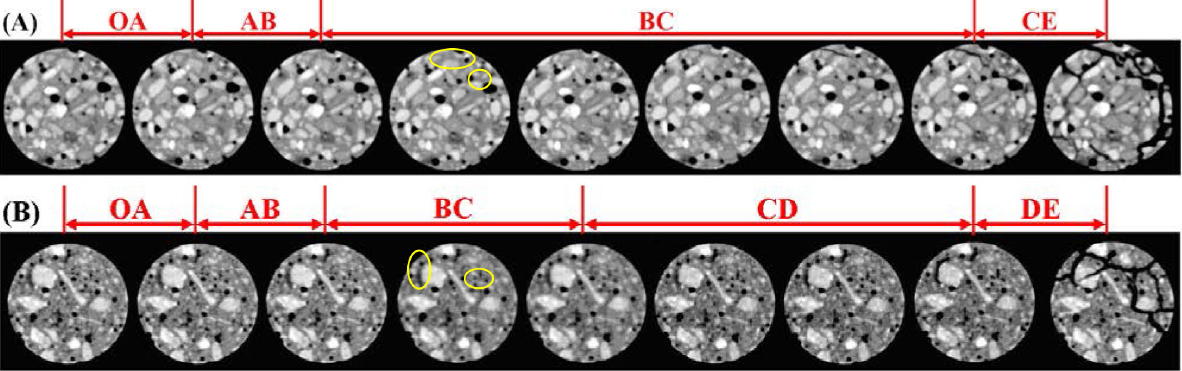
Fig. 7. CT images of the (A) (CONC_01) static and (B) (CONC_06) dynamic loading cases (yellow circles indicate the positions of initial cracks)